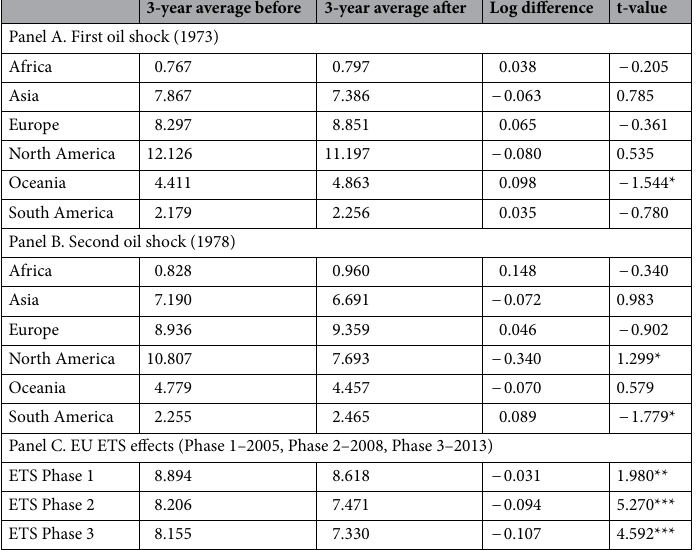
Table 2. Univariate comparison analyzing the effects of oil crises, financial crisis, and ETS